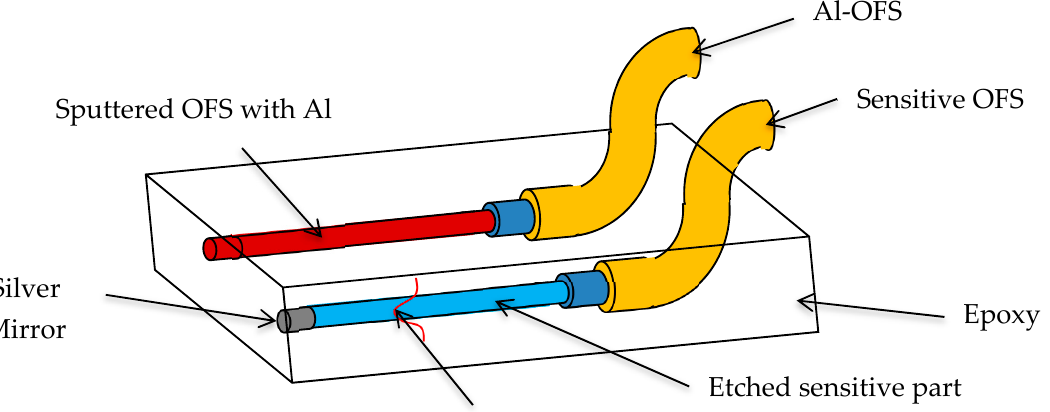
Figure 1. Scheme of an embedded optical fiber sensor (OFS) and sputtered OFS with aluminum (Al-OFS) in an epoxy polymer matrix (adapted from Reference [10]).